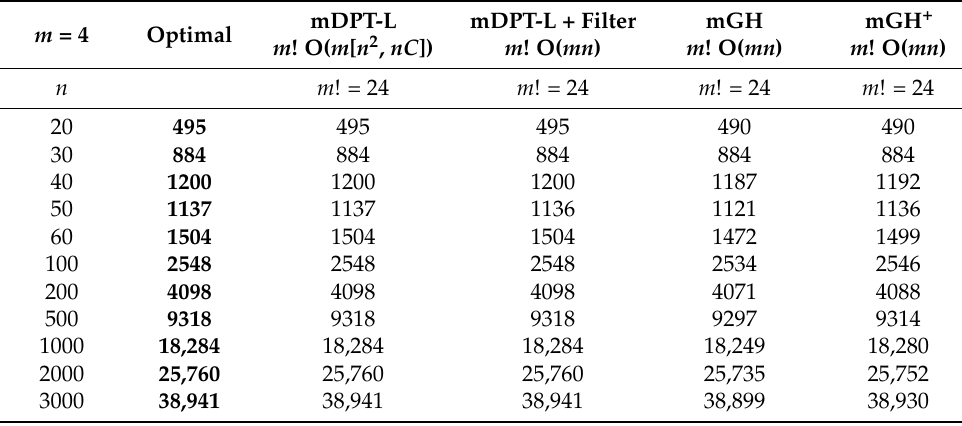
Table 7. Results (total profits) of datasets with capacities C ± 20 ( m = 4).